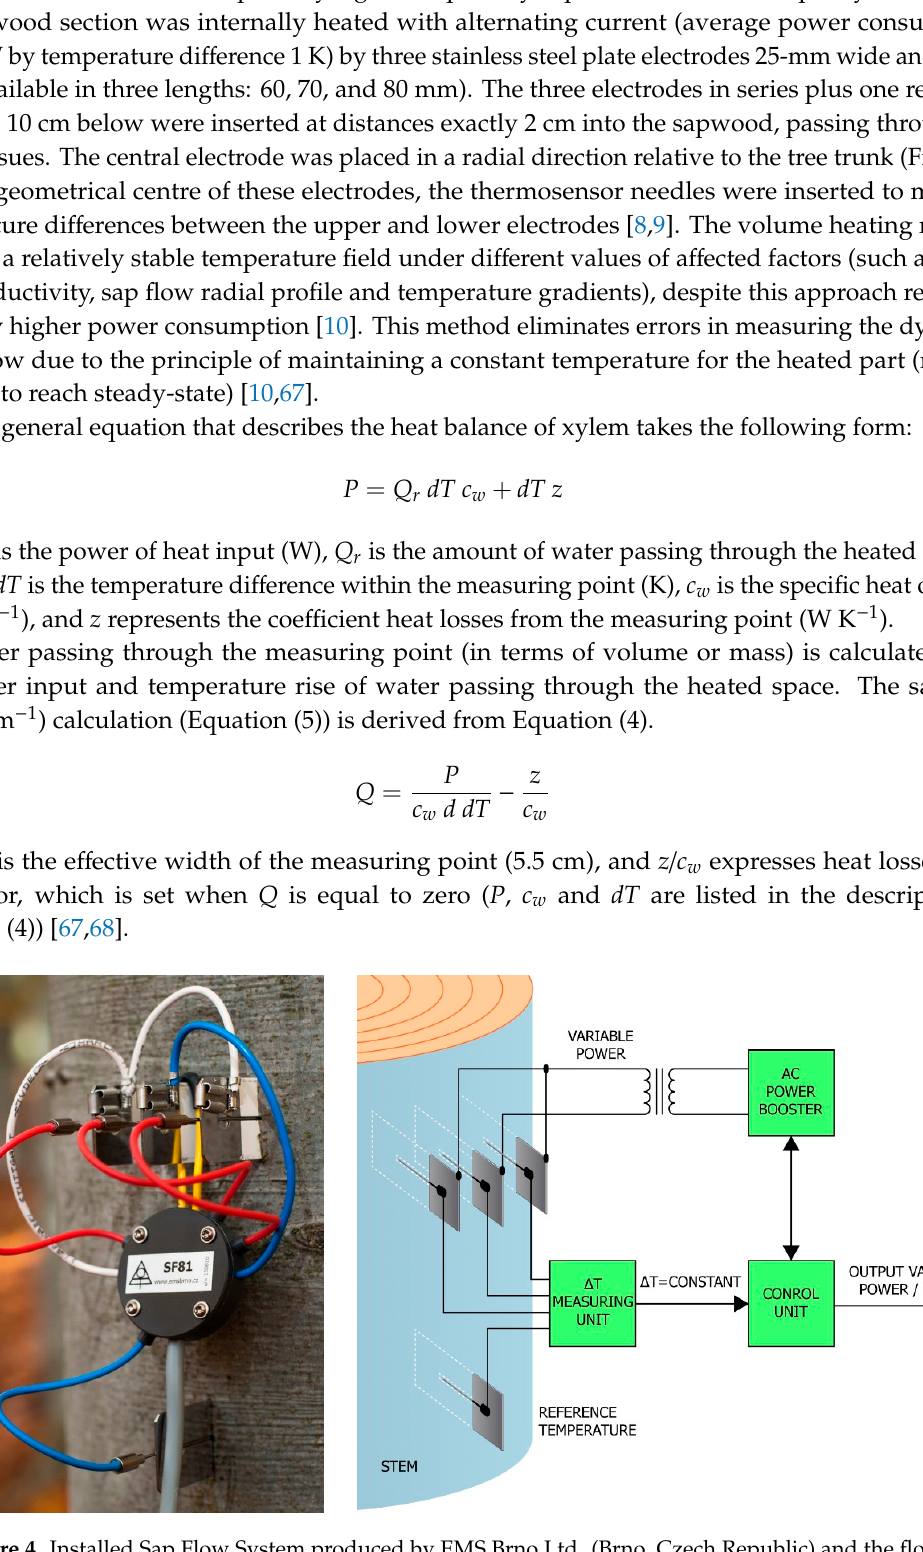
Figure 4. Installed Sap Flow System produced by EMS Brno Ltd. (Brno, Czech Republic) and the flows chart of measuring process. Sap flow values are calculated directly from the P/dT ratio.